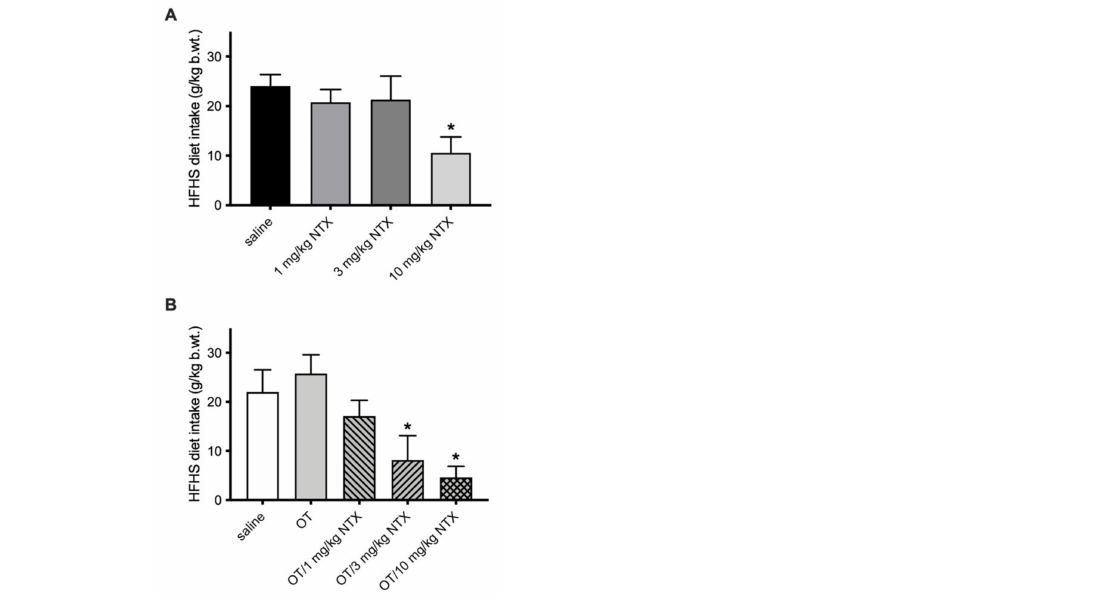
Figure 2. Episodic 2 h HFHS diet intake in nondeprived rats injected IP with: ( A ) saline, 1 mg/kg NTX, 3 mg/kg NTX, or 10 mg/kg NTX; or ( B ) saline, 0.1 mg/kg OT, 0.1 mg/kg OT + 1 mg/kg NTX, 0.1 mg/kg OT + 3 mg/kg NTX, or 0.1 mg/kg OT + 10 mg/kg NTX. * − p < 0.05 (significantly different from saline controls).